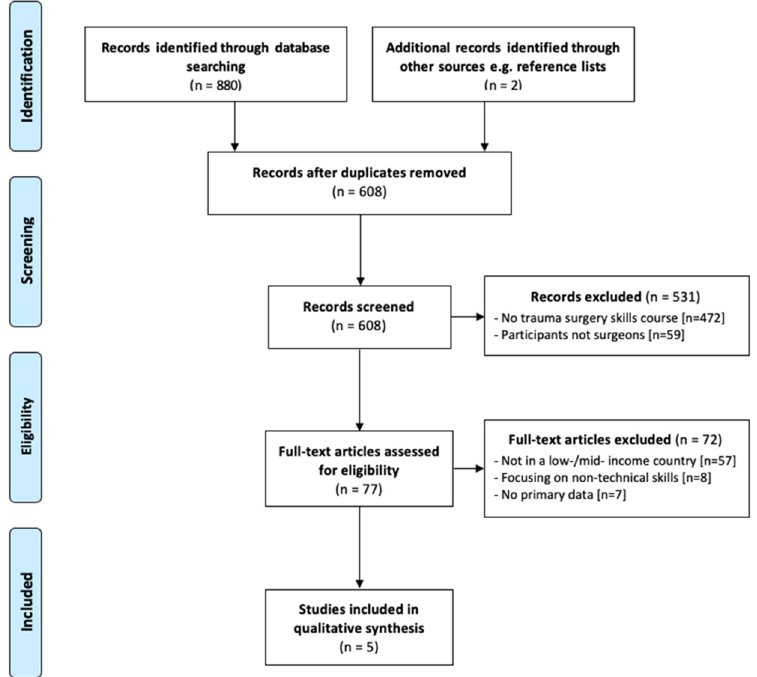
Figure 1. PRISMA flow diagram.